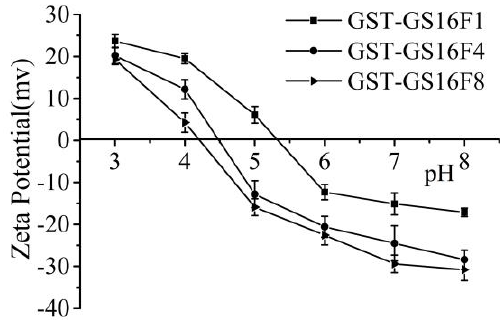
Figure 7. Zeta-potential in different pH environments of fusion proteins.